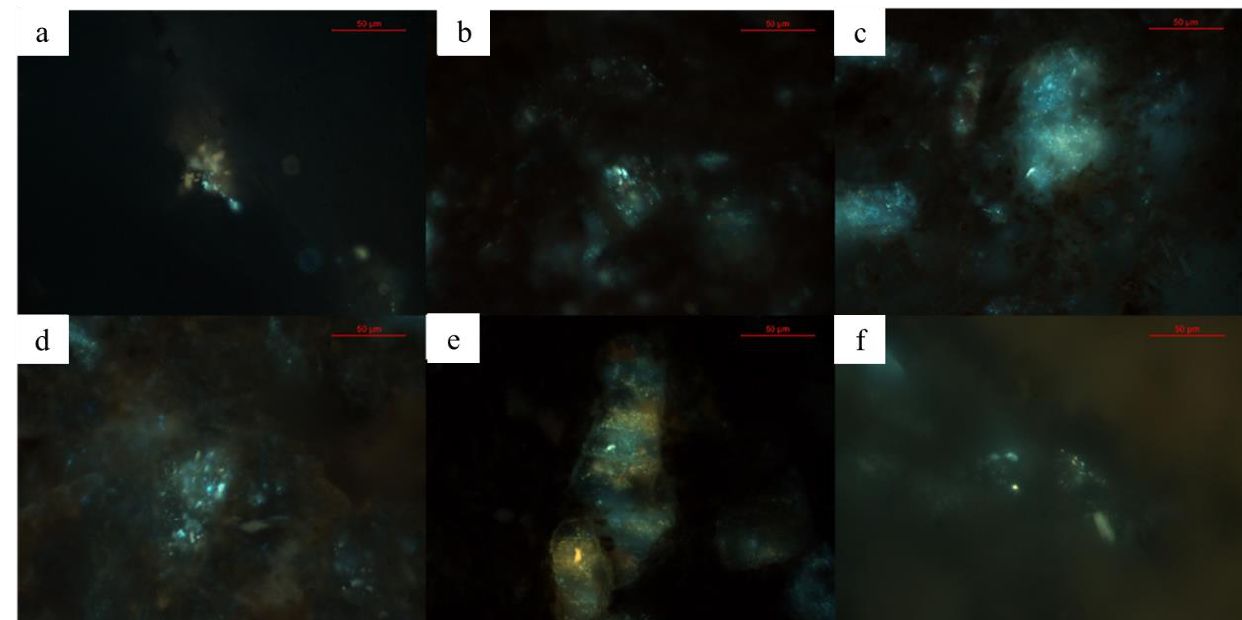
Figure 11. Fluorescence photos of hydrocarbon inclusions coexisting with different maturity. ( a ) Well M19, 3534.1 m, distributed along the microcracks of quartz grain, showing yellow or blue- green fluorescence; ( b ) well M217, 4010.02 m, distributed along micro-fractures of analcime cement, showing blue-green or yellow-green fluorescence; ( c ) well M217, 4010.02 m, distributed in belts along micro-fractures of quartz grain, showing blue-green fluorescence; ( d ) well YB4, 3871 m, distributed in belts along the micro-fractures of quartz particles, showing yellow-green or bluish-green fluores- cence; ( e ) well YB4, 3914 m, distributed in belts along micro-fractures of quartz particles, showing yellow or yellow-green fluorescence; ( f ) well D15, 4249 m, distributed in belts along micro-fractures of quartz particles, showing yellow, blue or yellow-green fluorescence.